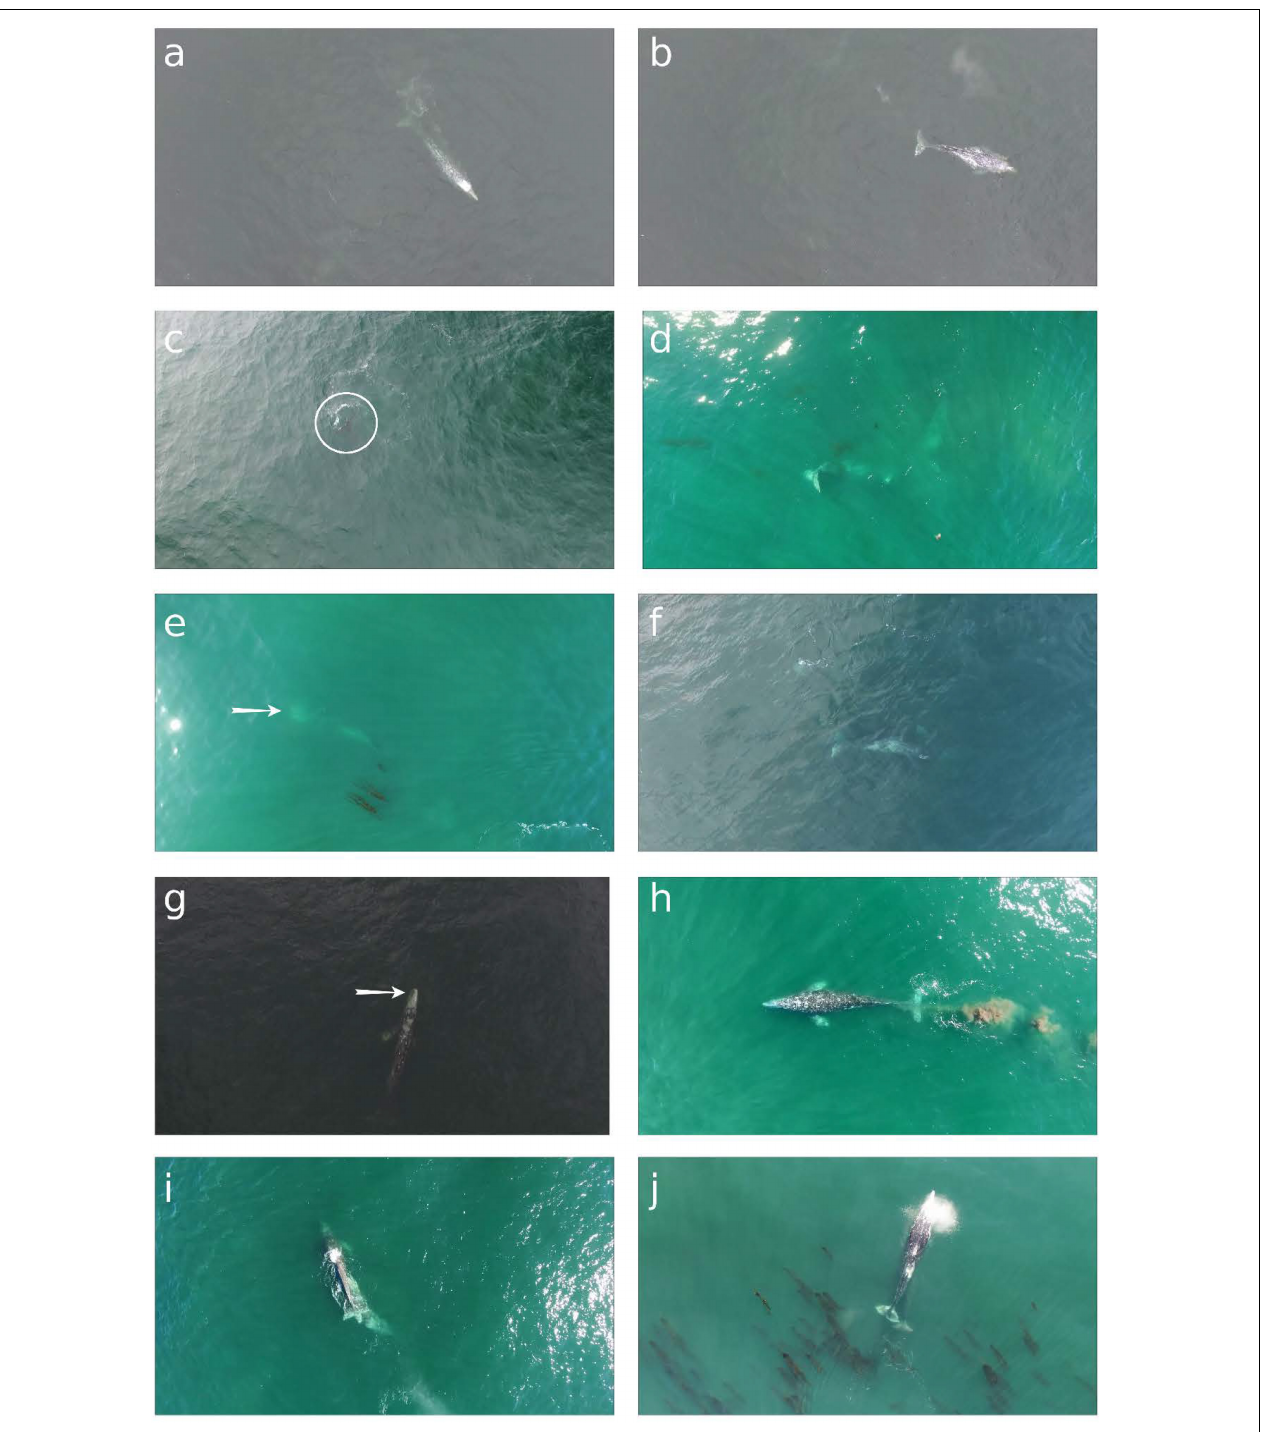
FIGURE 4 | Still images captured from unmanned aerial system (UAS) overflights of gray whales off the Oregon, United States coast illustrating different behavior events (see Table 1 for descriptions): (a) “bubbles from mouth” can be seen streaming from left side of mouth, which was followed 39 s later by (b) “sediment from mouth” that is gray/brown steam of small clouds coming from left side of mouth; (c) white circle highlights fluke of whale performing a “headstand”; (d) two whales engaged in “headstand” foraging together; (e) whale engaged in “side-swim”, arrow points to open mouth; (f) whale swimming “upside-down”, which persisted for 3 min; (g) arrow points to “open mouth at surface” of whale as it swims forward; (h) “defecation” event; (i) a “bump/tactile interaction” event as one whale pushes with its head into the underside of another whale’s caudal region; (j) nursing behavior observed as calf aligns under mother’s ventral area (see Supplementary Material of UAS video clips of behavior